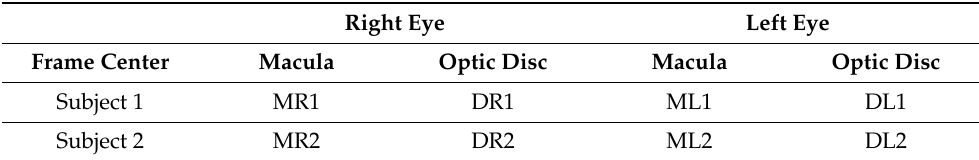
Figure 2. Original images. Retinographies of the pair (MR2/DR2) taken from subject 2′s right eye, with the frame centered on ( a ) macula (MR2); ( b ) optic disc (DR2). Table 3. Retinography labels according to subject, eye, and frame